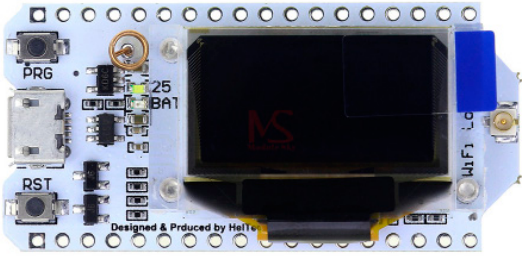
Figure 9. Heltec WiFi LoRa 32.